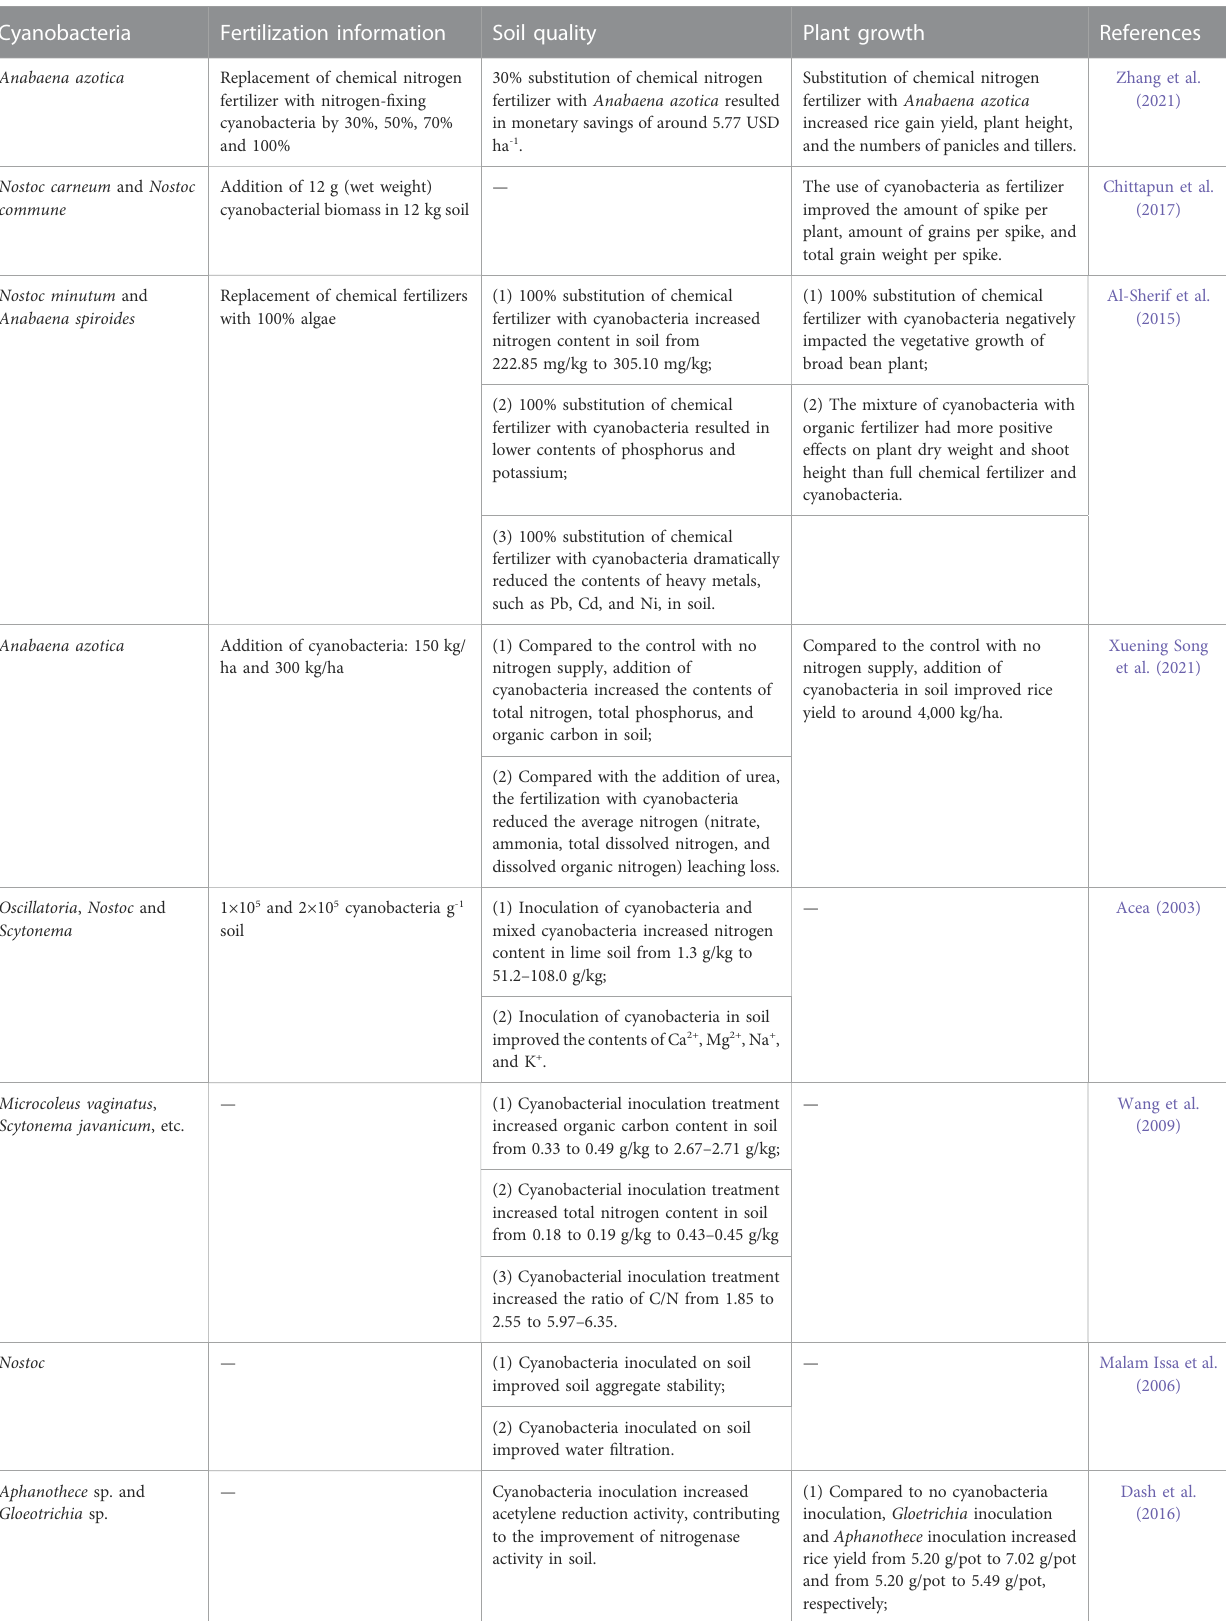
TABLE 1 Utilization of cyanobacteria as fertilizer to improve soil fertility and enhance plant growth.